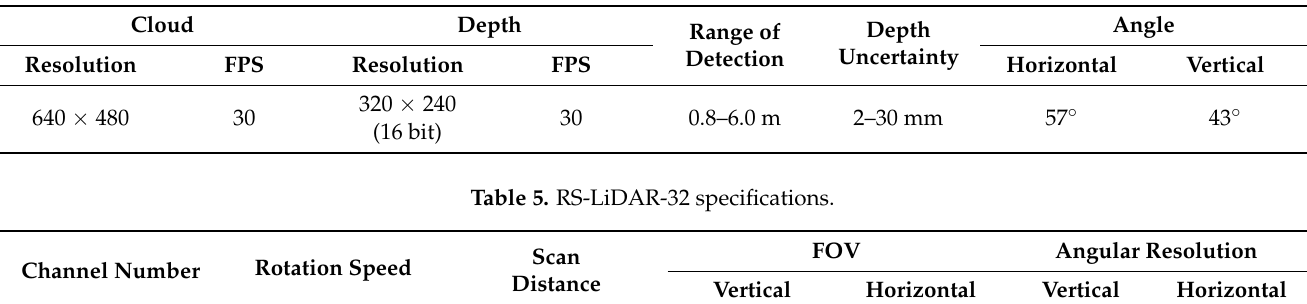
Table 4. Kinect 1.0 specifications.